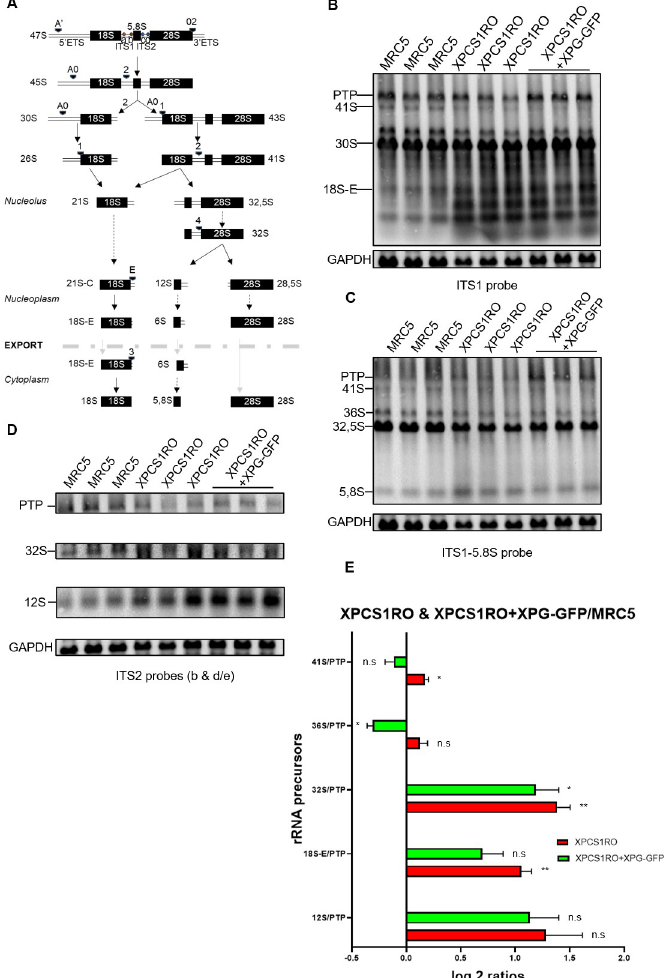
Fig 4. The absence of XPG leads to an increase of alternative rRNA precursors. A) Scheme of the processing of the rRNA in human cells with the location of the Northern Blot probes. a: Probe ITS1; b: Probe ITS1-5.8S; c: Probe ITS2b; d: Probe ITS2 d/e; Arrows: Endonucleolytic cleavage; Dotted arrows: Action of an exoRNase; Grey arrows: Export through the nuclear membrane; Italic name: Localization of the precursor; Bold: Export of the precursor; Thick grey dotted line: Nuclear membrane. B-D) Northern blot analysis of the RNA of three biological replicates of MRC5-SV, XPCS1RO-SV and XPCS1RO-SV+XPG-GFP cell lines with the ITS1 (B), ITS1-5.8S (C) and ITS2b and d/e (D) probes. PTP: Primary Transcript Plus. E) Ratio Analysis of Multiple Precursors (RAMP) of various pre-rRNAs in XPCS1RO-SV and XPCS1RO-SV+XPG-GFP normalized to the same ratios in the MRC5-SV. The error bars represent the SEM of 3 biological replicates. Statistical significance was determined using the Holm-Sidak method relative to MRC5 value (0) in GraphPad Prism 8.1.0, with ⍺ = 0.05. n.s: Not significant; � : p < 0.05; �� : p < 0.01.